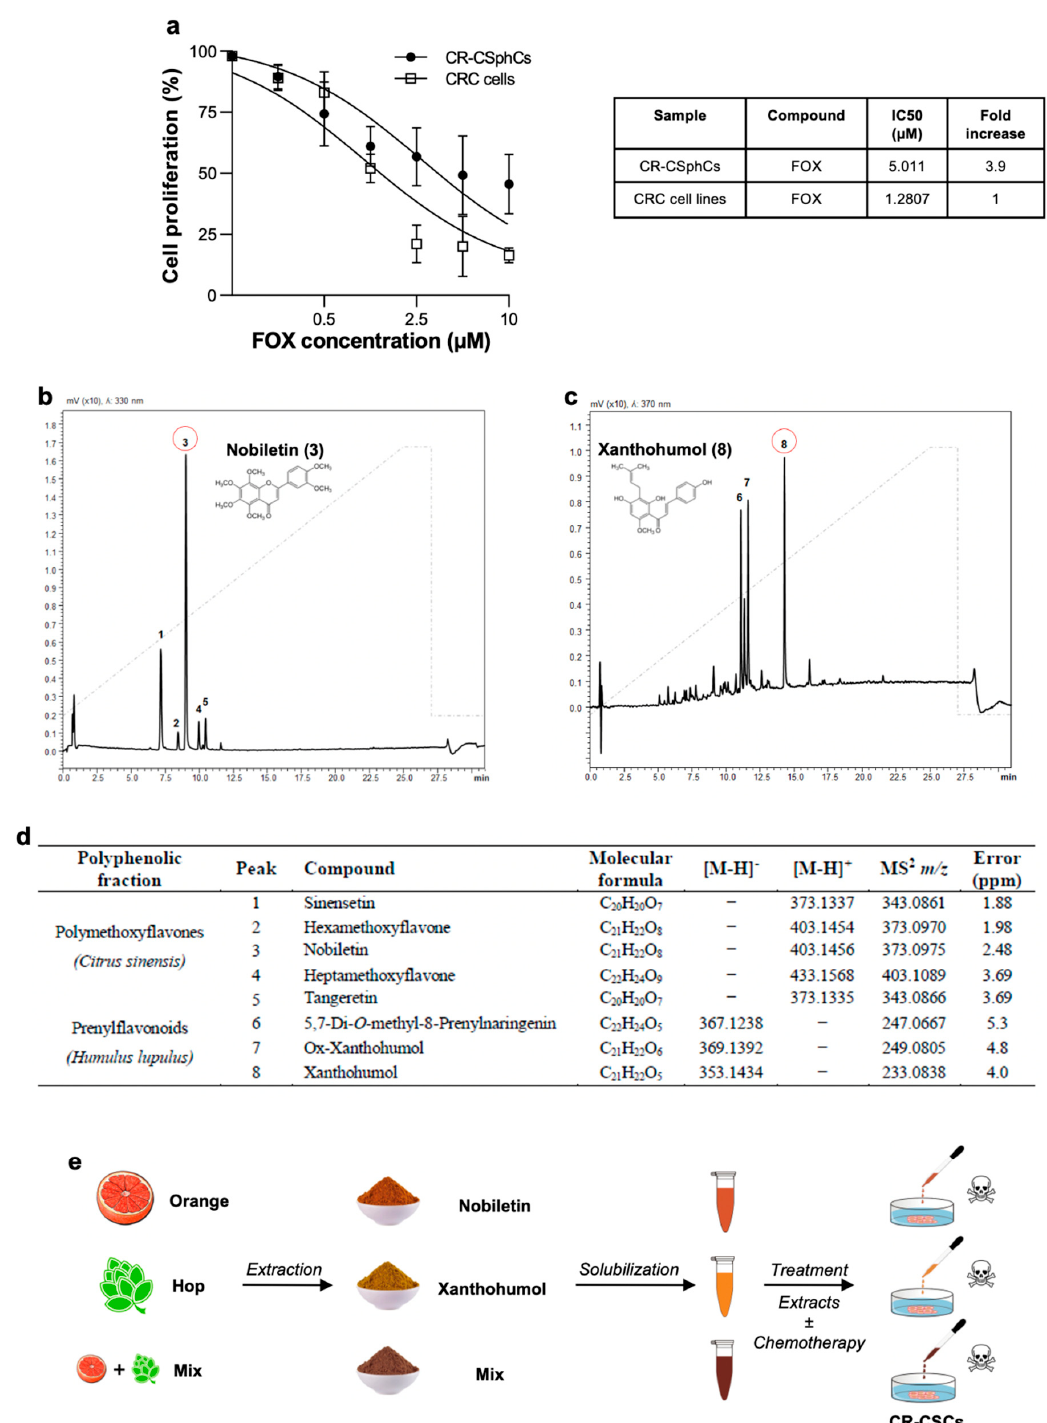
Figure 1. CR-CSphCs are resistant to chemotherapy. ( a ) Cell proliferation percentage of CR-CSphCs (#3, #8, and #59) and CRC cell lines (HCT116 and RKO) treated with 0.1 µ M, 0.5 µ M, 1 µ M, 2.5 µ M, 5 µ M, and 10 µ M of FOX chemotherapy for 48 h. Data are represented as mean ± SD of three independent experiments. IC50 values are indicated in the right panel; ( b ) chromatographic profiles of polymethoxyflavones and chemical structure of Nobiletin, isolated from Citrus sinensis; ( c ) chromatographic profiles of prenylflavonoids and chemical structure of Xanthohumol, isolated from Humulus lupulus; ( d ) qualitative profile of isolated polyphenolic fractions; ( e ) NCF, XCF, and Mix (50% NCF plus 50% XCF) were firstly extracted through lyophilization and then solubilized in methanol. CR-CSphCs and CRC cell lines were exposed to extracts, either singularly or in combination with FOX